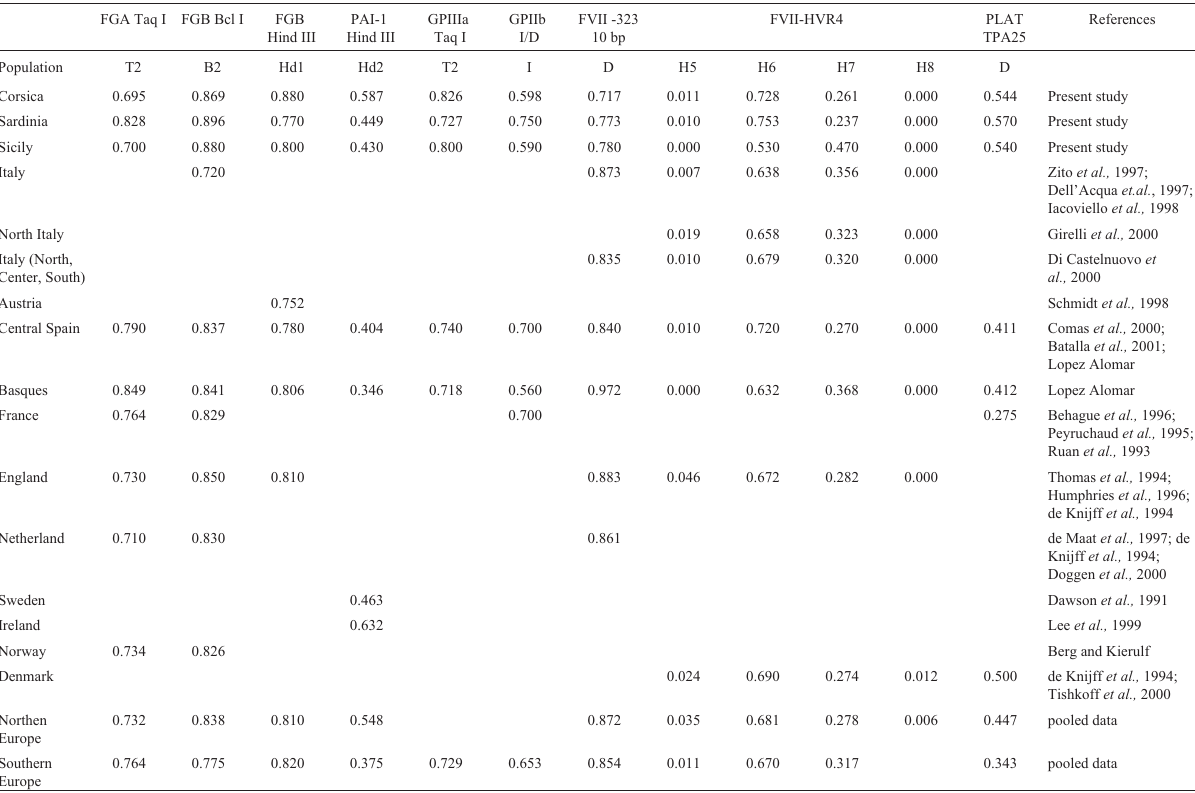
Table 4 - Allele frequencies in different ethnic